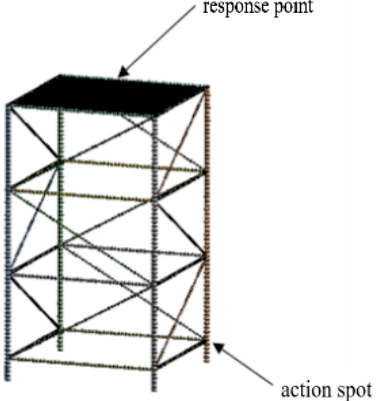
Table 5. The effect of local resonance width on vibration level.